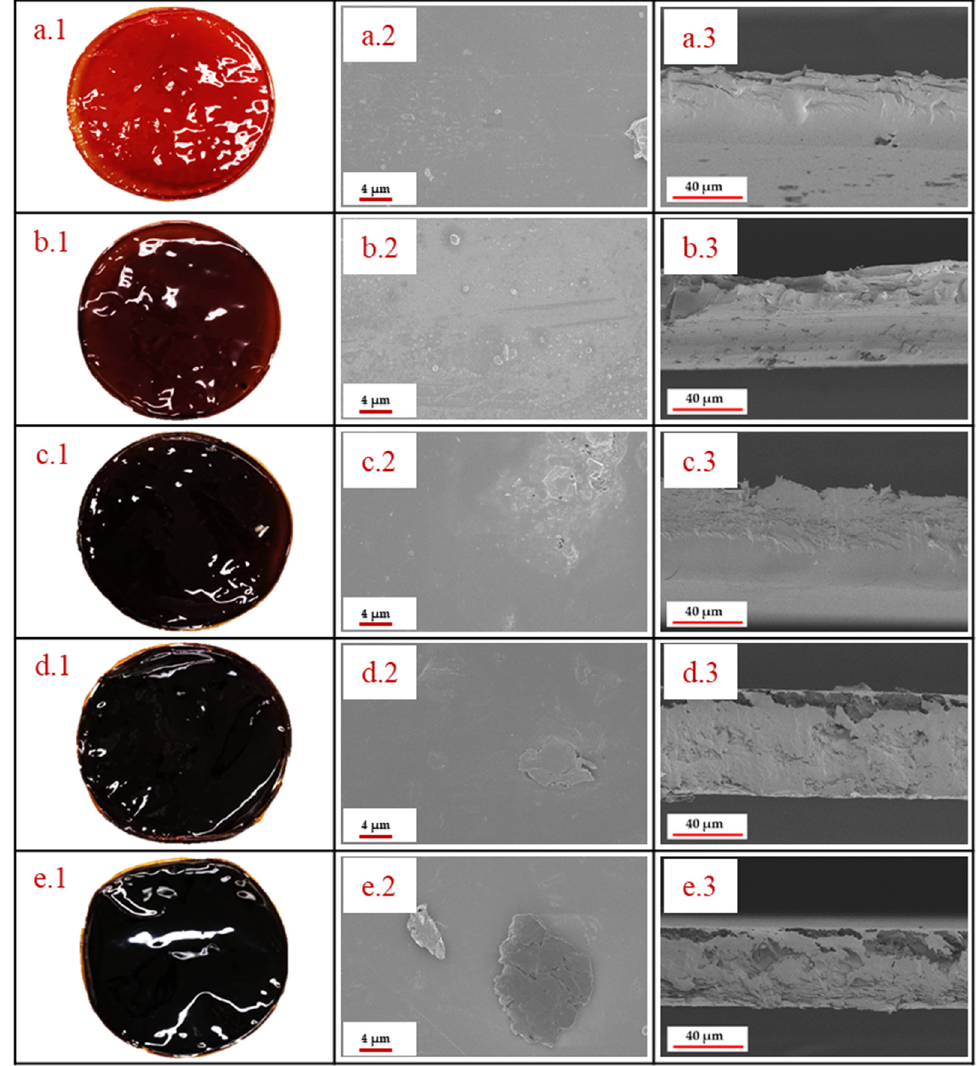
Figure 1. Photographs and SEM images of the PBI membranes: (( a .1)–( a .3)) Standard PBI membrane, (( b .1)–( b .3)) 0.5% GO–PBI membrane, (( c .1)–( c .3)) 1% GO–PBI membrane, (( d .1)–( d .3)) 2% GO–PBI membrane, (( e .1)–( e .3)) 3% GO–PBI membrane.